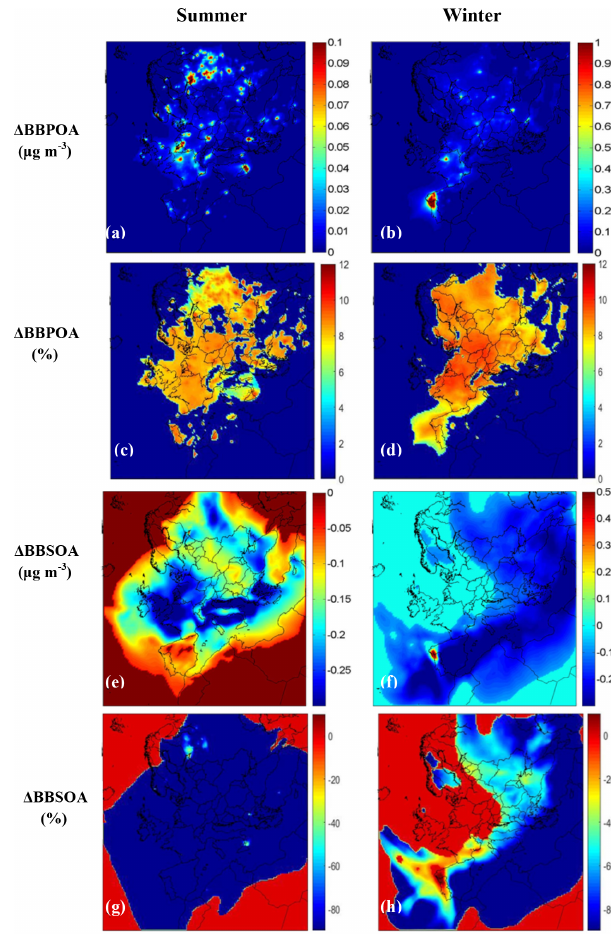
Figure 7. Average predicted absolute (µgm − 3 ) difference (sensi- tivity case minus base case) of ground-level PM 2 . 5 (a–b) BBPOA and (e–f) BBSOA concentrations from PMCAMx-SR base case and sensitivity simulations during the modeled periods. Also shown are the corresponding relative (%) change of ground-level PM 2 . 5 (c– d) BBPOA and (g–h) BBSOA concentrations during the modeled periods. Positive values indicate that the PMCAMx-SR sensitivity run predicts higher